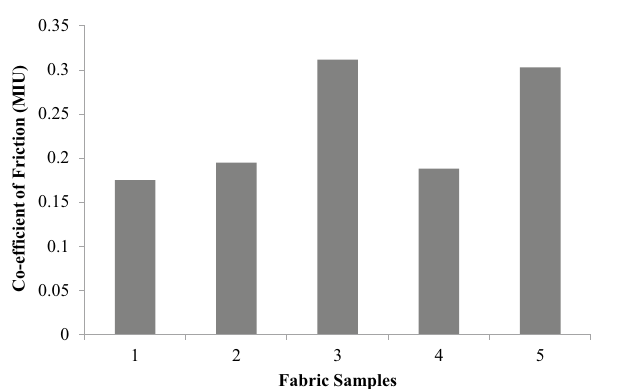
Figure 17. ( a ) Scanning electron microscopic image of 100% cotton control fabric. ( b ) Scanning electron microscopic image of 65/35 micro-denier polyester/cotton control fabric. ( c ) Scanning electron microscopic image of 65/35 micro-denier polyester/cotton sericin and glutaraldehyde finished fabric. ( d ) Scanning electron microscopic image of 65/35 micro-denier polyester/cotton (plasma-treated sericin and glutaraldehyde finished) fabric.